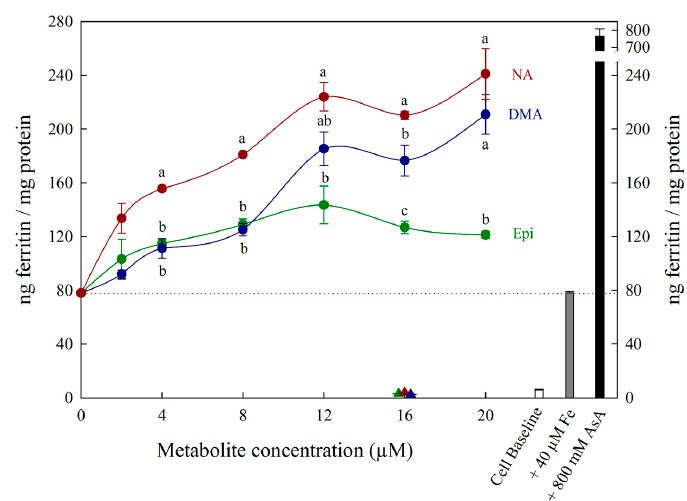
Figure 2. Ferritin formation in Caco-2 cells in response to varying concentrations (0–20 µ M) of nicotianamine (NA, red), 2’ deoxymugineic acid (DMA, blue) and epicatechin (Epi, green) at concentrations varying between 0–20 µ M in solution with Fe (40 µ M). Triangles indicate ferritin formation in metabolite solutions (16 µ M) without Fe. Dotted line indicates ferritin response to 40 µ M Fe alone and is extended to both y axes to facilitate comparison with other treatments. Error bars represent standard error of the mean of three replicates. Different letters indicate significantly different ferritin formation between metabolites of the same concentration as analyzed by one-way ANOVA with Tukey post-hoc test ( p < 0.05).